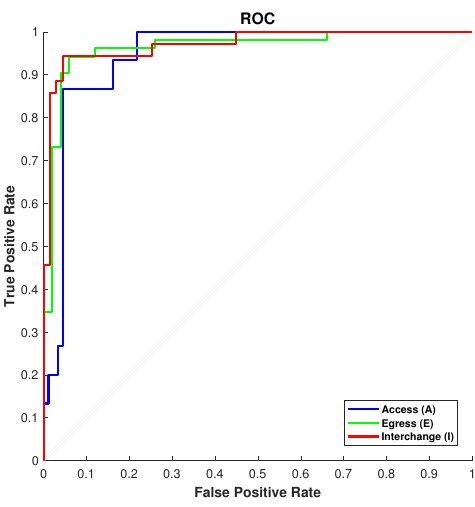
Figure 7. Receiver operating characteristic (ROC) curve for three classes Access (A), Egress (E), and Interchange (I) representing the specificity pair corresponding to a AEI Framework decision threshold. Grey line in the middle of the plot is a threshold line between True Positive and False Positive Ratios.